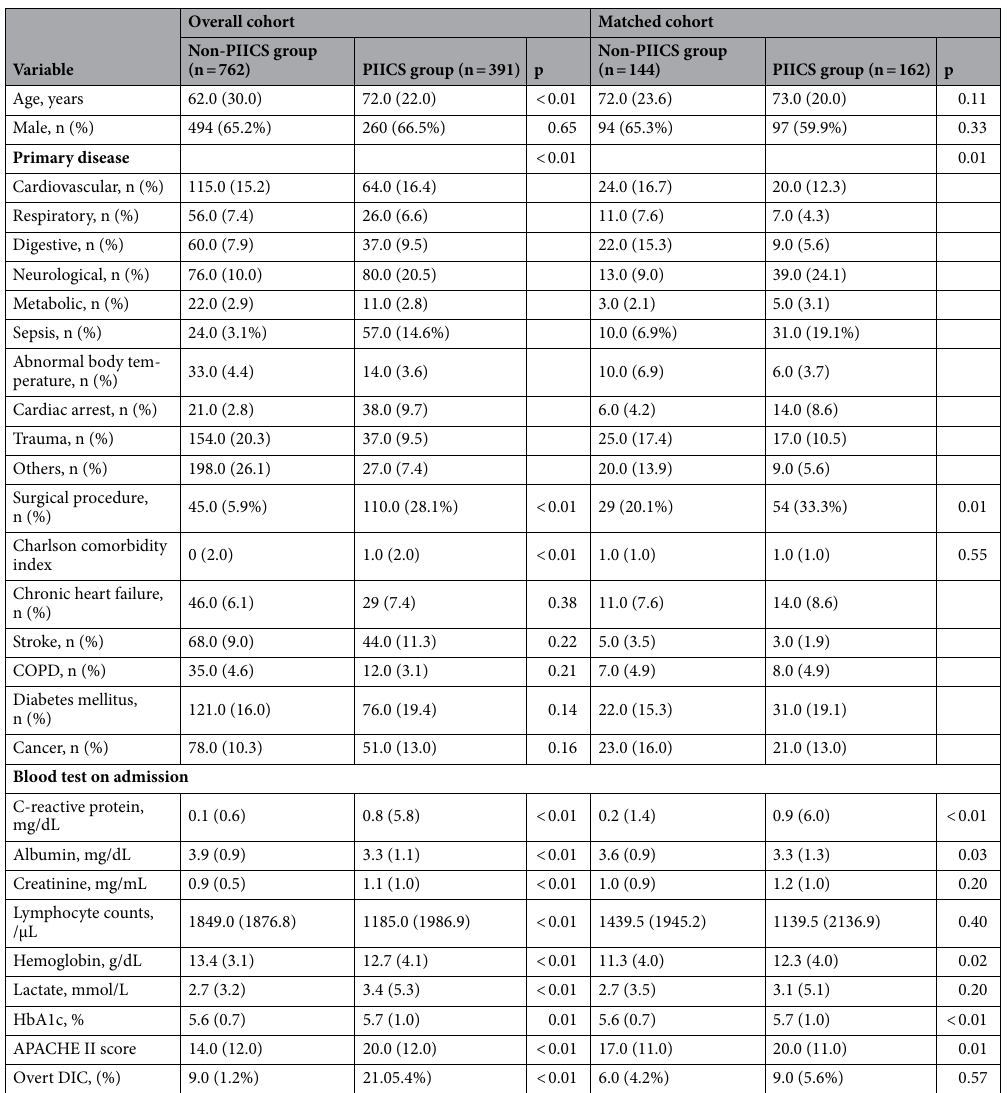
persistent inflammation, immunosuppression, and catabolism